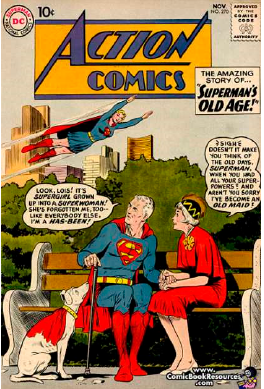
Figure 4. Action Comics #270, “The Old Man of Metropolis!” (November 1960) [10].